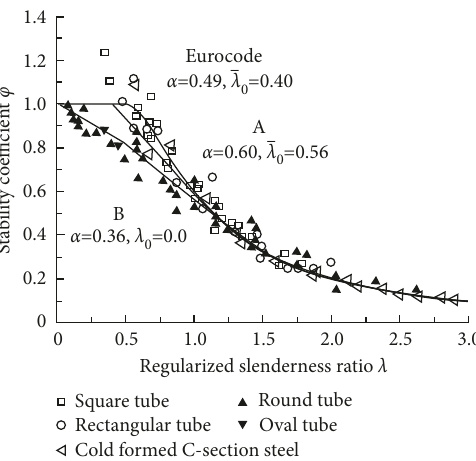
Figure 1: Strength curves in Eurocode and the proposed strength curves for A and B.